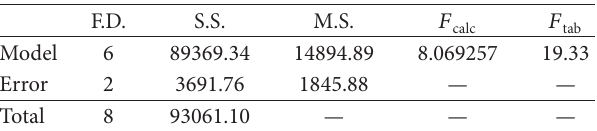
T 8: Analysis of variance for storage time determined by Rancimat